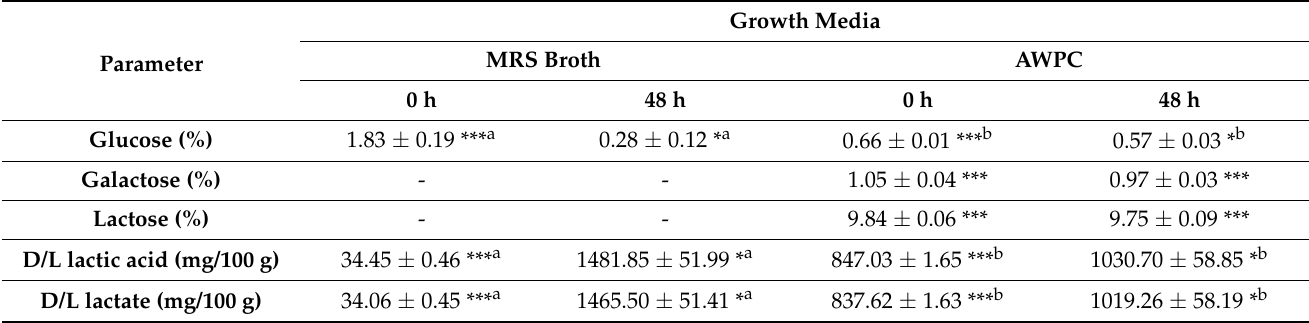
Table 3. Time course of lactic acid and lactate production and reducing sugars consumption of selected L. paracasei A11 in MRS broth and acid whey protein concentrate (AWPC).